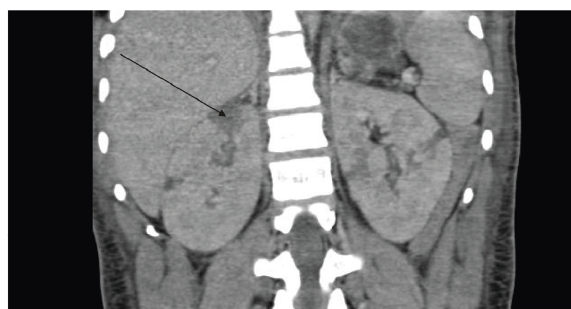
Figure 1: Computed tomography (CT) of the abdomen showing multiple hypodense wedge-shaped parenchymal defects involving the cortex and medulla consistent with renal infarcts (black arrow).